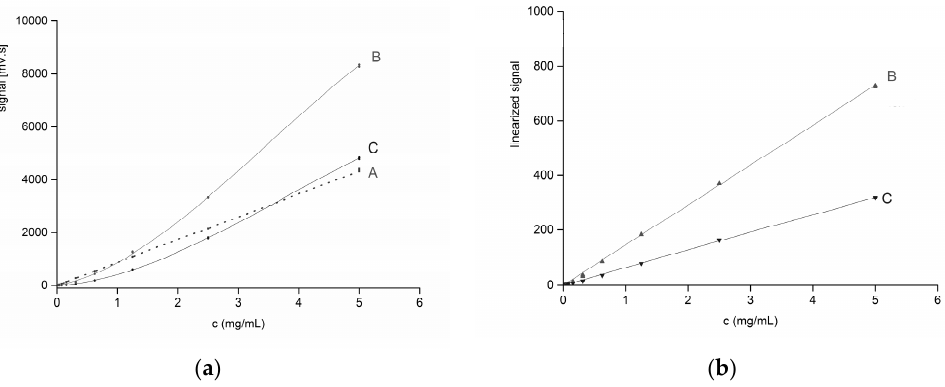
Figure 2. ( a ) Calibration curves of salicin (A, UV-detector λ = 270 nm, linear), and salicin with glucose (B, C, ELSD; non-linear); calibration points are connected by a cubic function only to visualize the course since there is no hard model for ELSD calibration functions; ( b ) Linearization of the ELSD calibration curves (B, C); peak areas were replaced by a function (area)x with exponents of x = 0.73 and 0.68, respectively [13]. Every concentration level was measured in triplicate. Experimental conditions: the mobile phase was 90% acetonitrile/10% water, flow rate was 2 mL/min, 25 °C, and injection volume was 10 µL.